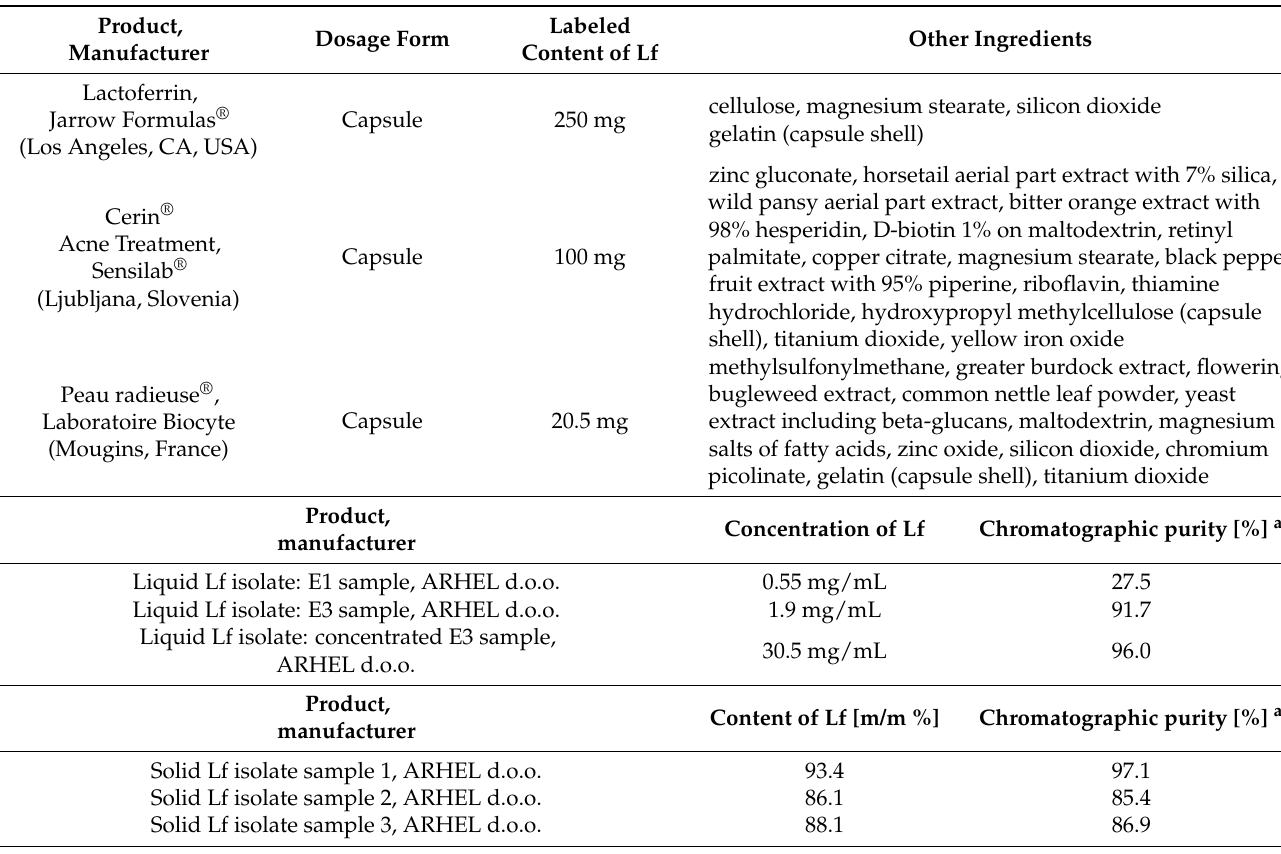
Table A1. Extended data of tested products containing